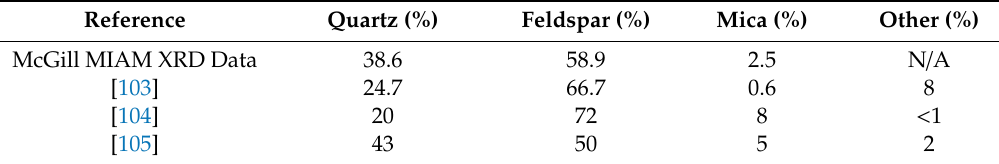
Table 1. Mineralogical composition of the Stanstead granite.